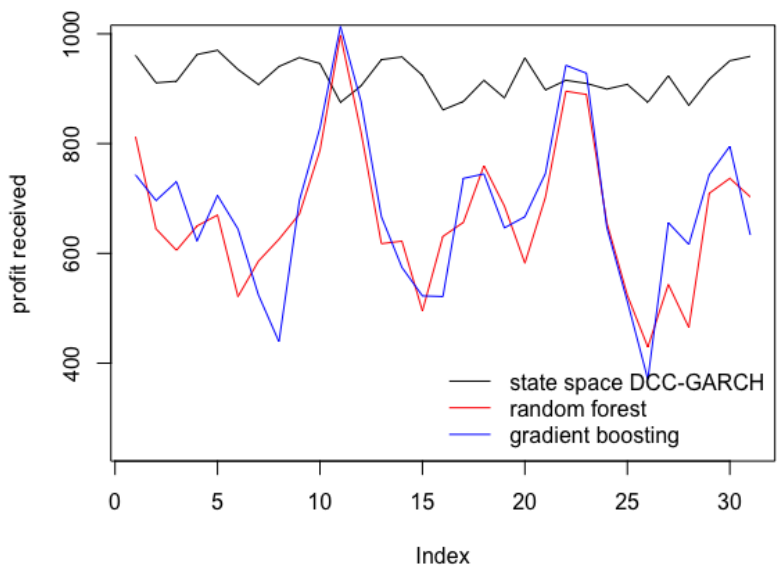
Figure 8. Amount of received profit for tested methods by time period.